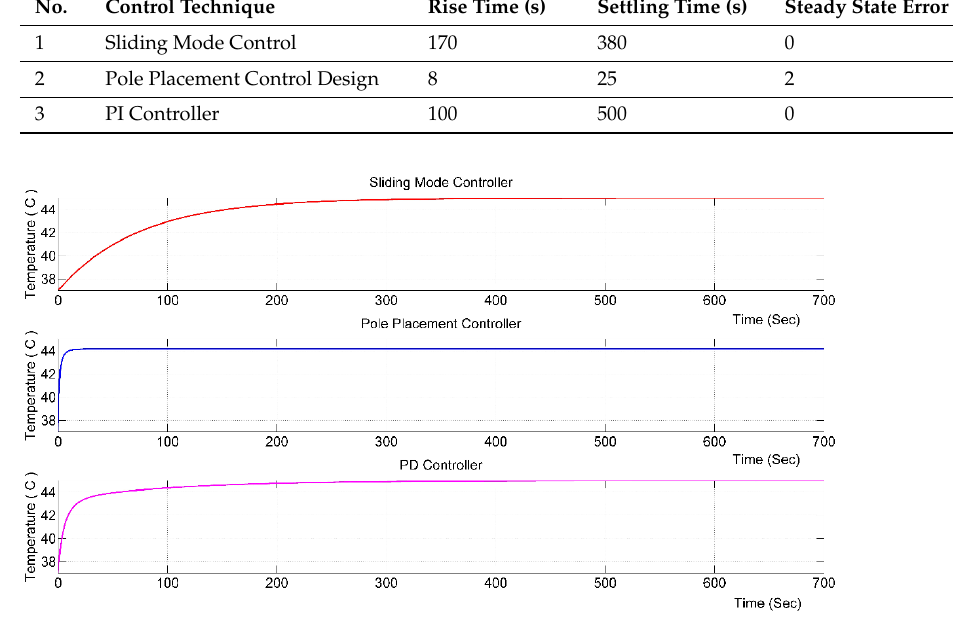
Figure 13. Combined step responses of all controllers.